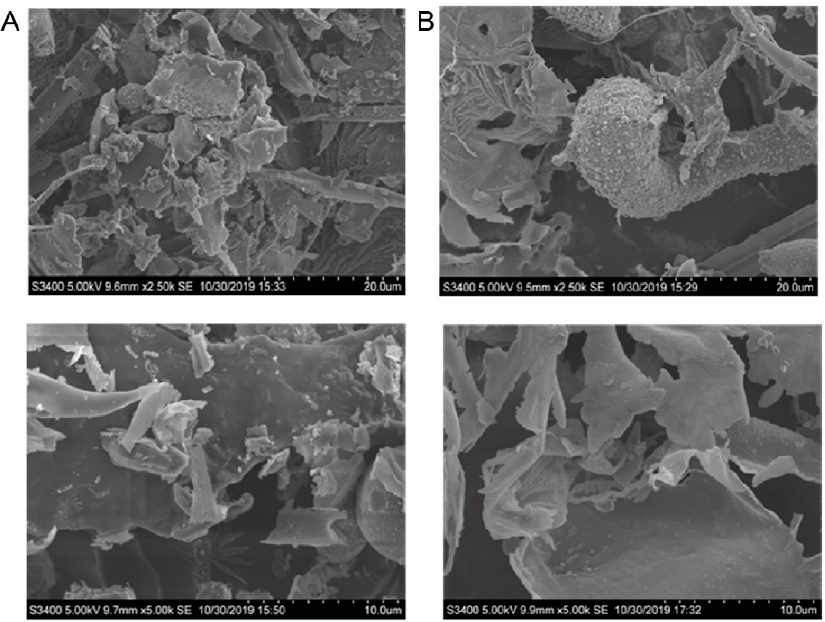
Figure 7. SEM images of CTLP ‐ 1 ( A ) and CTLP ‐ 2 ( B ) at 20 nm and 10 nm.